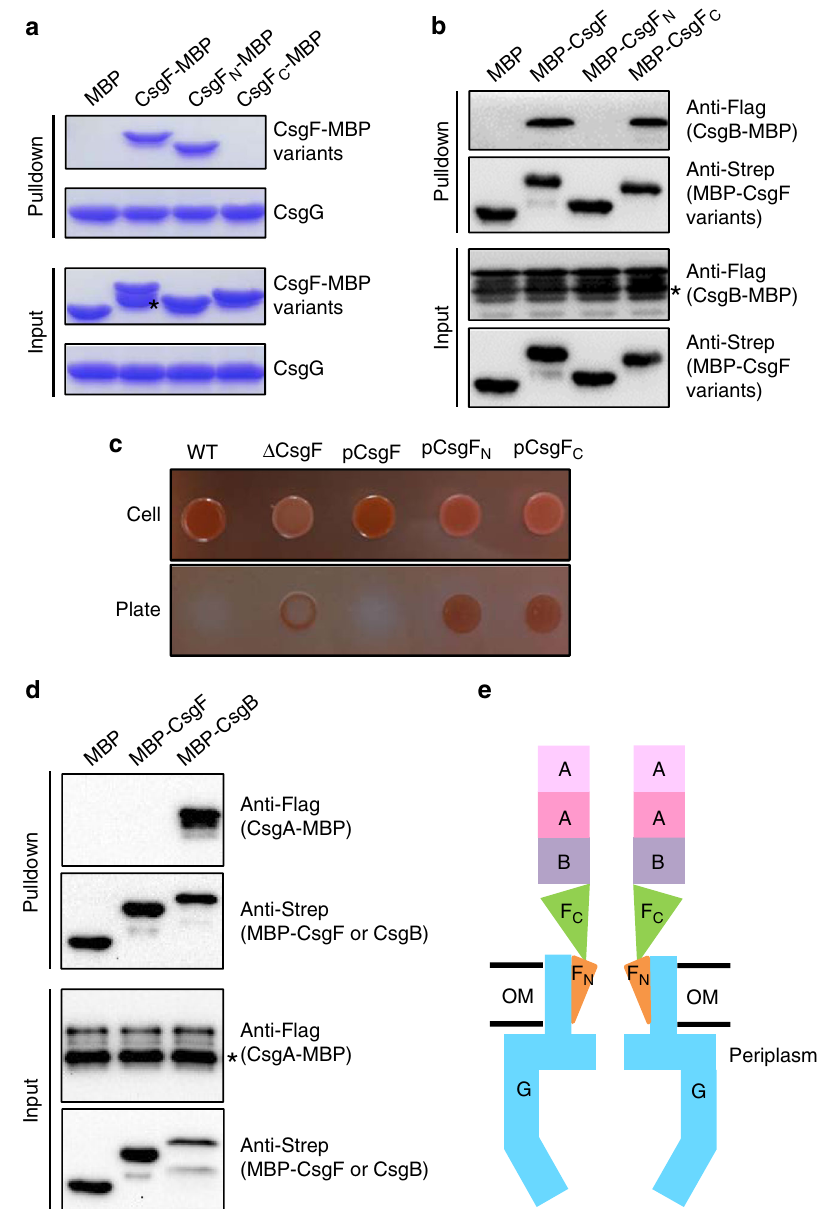
Fig. 3 Interactions between major components of curli biogenesis system and its assembly model. a Pulldown assay with CsgG and different parts of CsgF (C-terminal MBP tag). * Indicates CsgF degradation. Source data are provided as a Source Data fi le. b Pulldown assay with CsgB(C-terminal MBP tag) and different parts of CsgF (N-terminal MBP tag). * Indicates CsgB degradation. Source data are provided as a Source Data fi le. c Congo red cell-association assay for different parts of CsgF. Source data are provided as a Source Data fi le. d Pulldown assay of CsgF(N-terminal MBP tag), CsgB(N-terminal MBP tag) and CsgA(C-terminal MBP tag). * Indicates CsgA degradation. Source data are provided as a Source Data fi le. e Overall assembly model of curli biogenesis system. OM outer